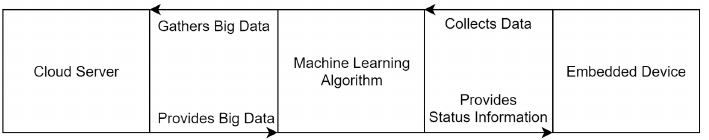
Figure 7. Schematic of feedback learning structure.